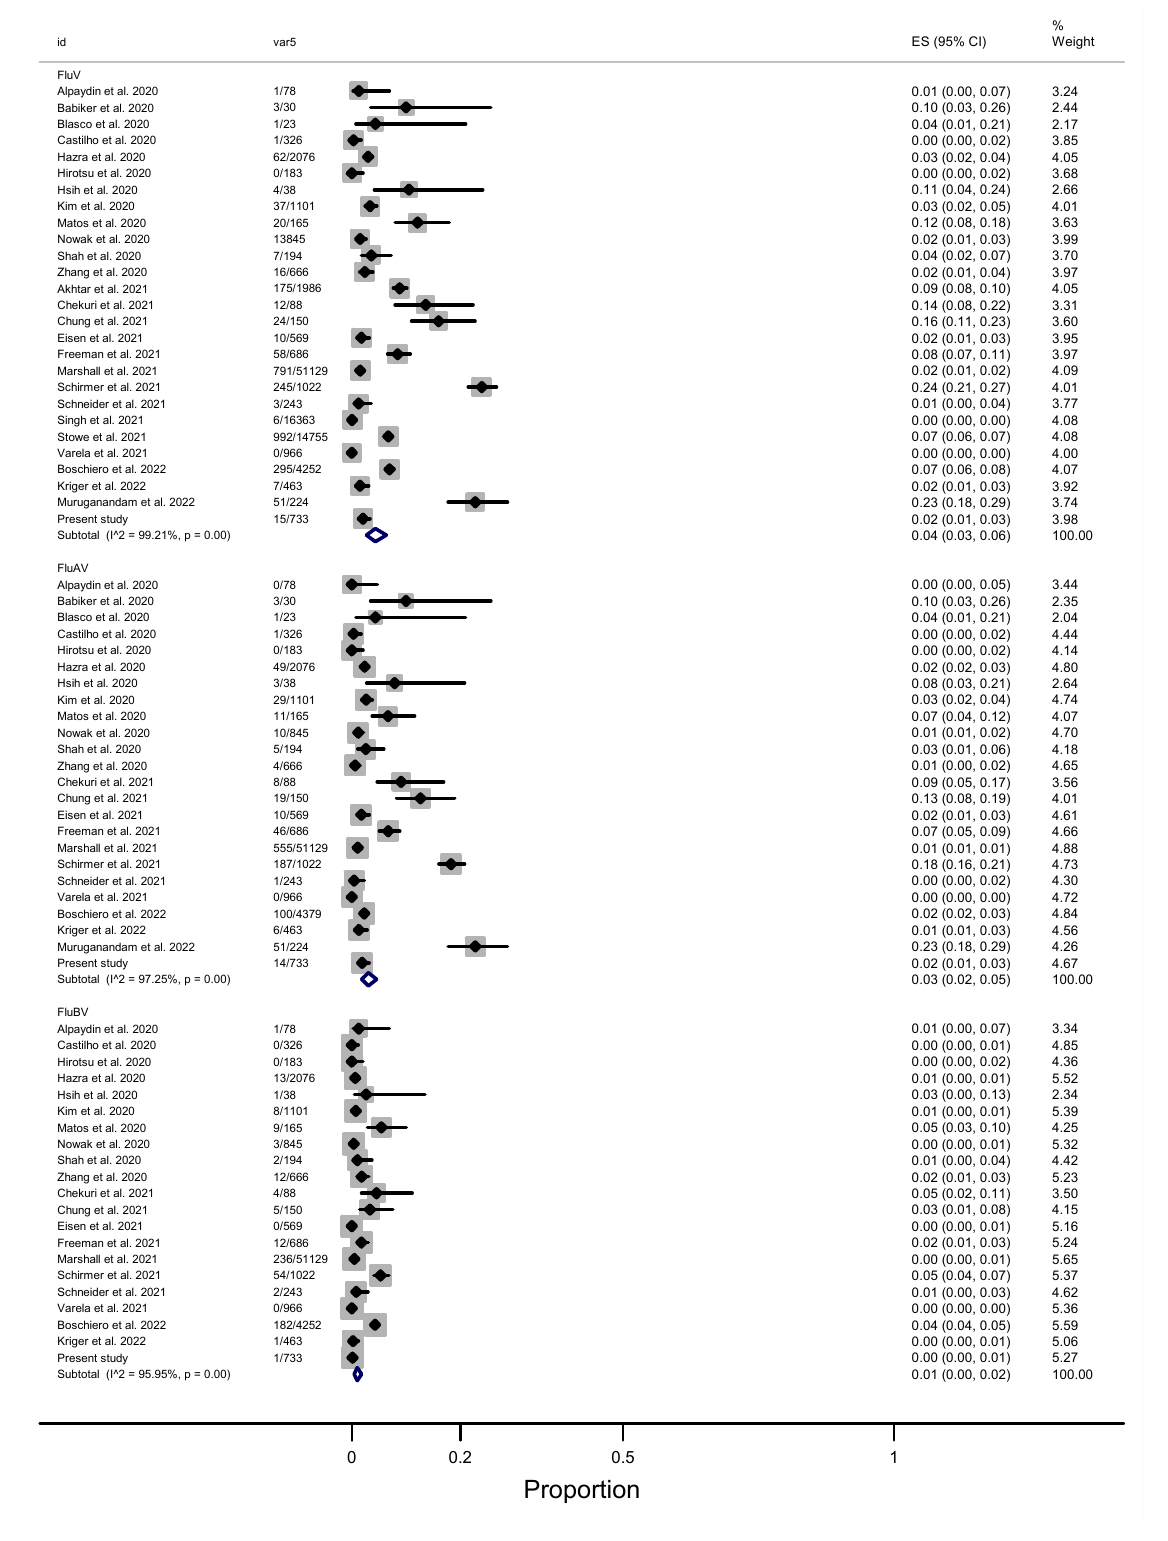
Figure 2. Forest plot with FluV, FluAV, and FluBV positivity among SCNG patients. The black diamonds in gray squares indicate the mean of the ratio of viral positivity, while the size of the grey square represents the weight (population size) contributed by each study in the meta-analysis. The horizontal lines in black represent their 95% CI. The blue diamond represents the pooled ratio of positives and its 95% CI. Id = identification of the study; Var5 = FluV positivity/total; ES = effect size